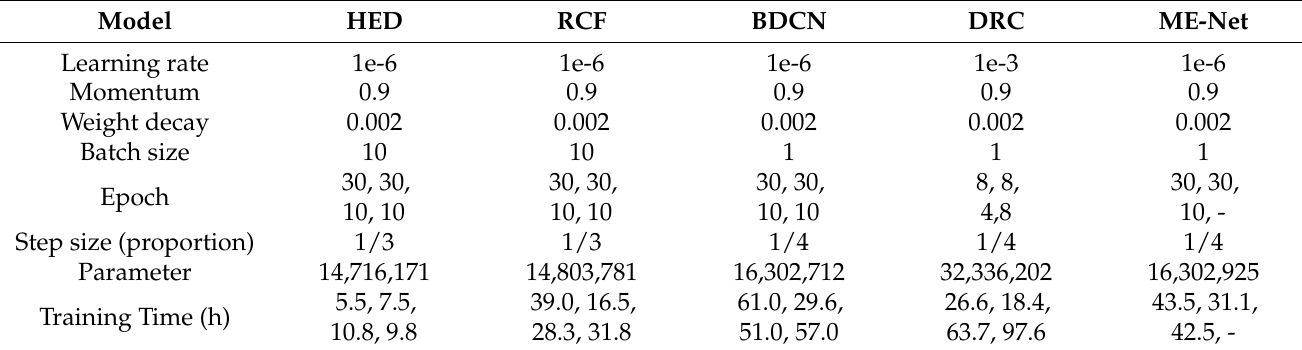
Table 1. Hyperparameters and time of training DCNNs-based edge detection models on Jiangbei, Massachusetts, Inria and BSDS500 1